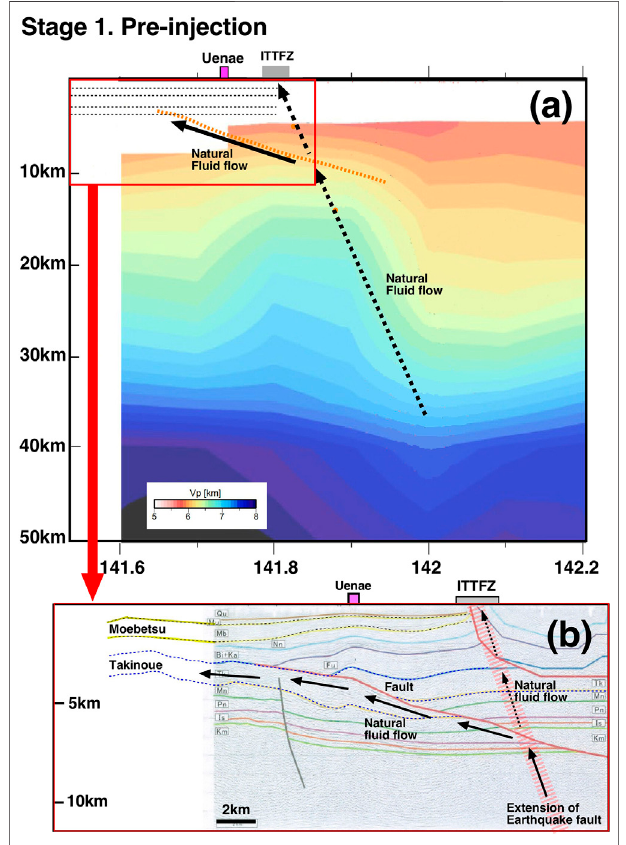
FIGURE 3 | Schematic vertical cross-section of the Hokkaido Iburi region along the H91-3 seismic pro fi le of Figure 1 , and its extension southwest and northeast before CCS-CO 2 injection (A) P-wave velocity (Vp) structure of the crust and uppermantle in the region. The orange dotted curve shows a fault determined by seismic re fl ection survey, which corresponds to the red solid line in bottom fi gure. The black solid and dotted arrows show possible natural fl uid fl ows in the region supported by a seismological study. (B) Modi fi ed subsurface structure of the seismic section alongH91-3in Figure1 reportedbyYokokuraetal.(2014).Redsquareoftop fi gure is enlarged here. The red solid line is the active fault. Uenae and ITTFZ denote the position of Uenae site and